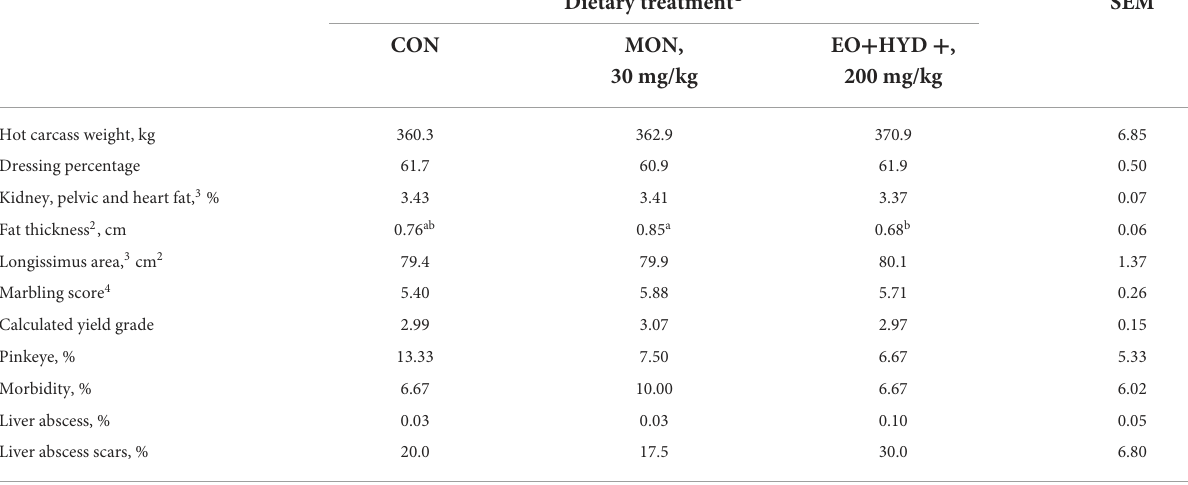
TABLE 3 Influence of feeding an eubiotic blend of essential oils plus 25-hydroxy-vit-D3 on carcass characteristics and health score of calf-fed Holstein steers.